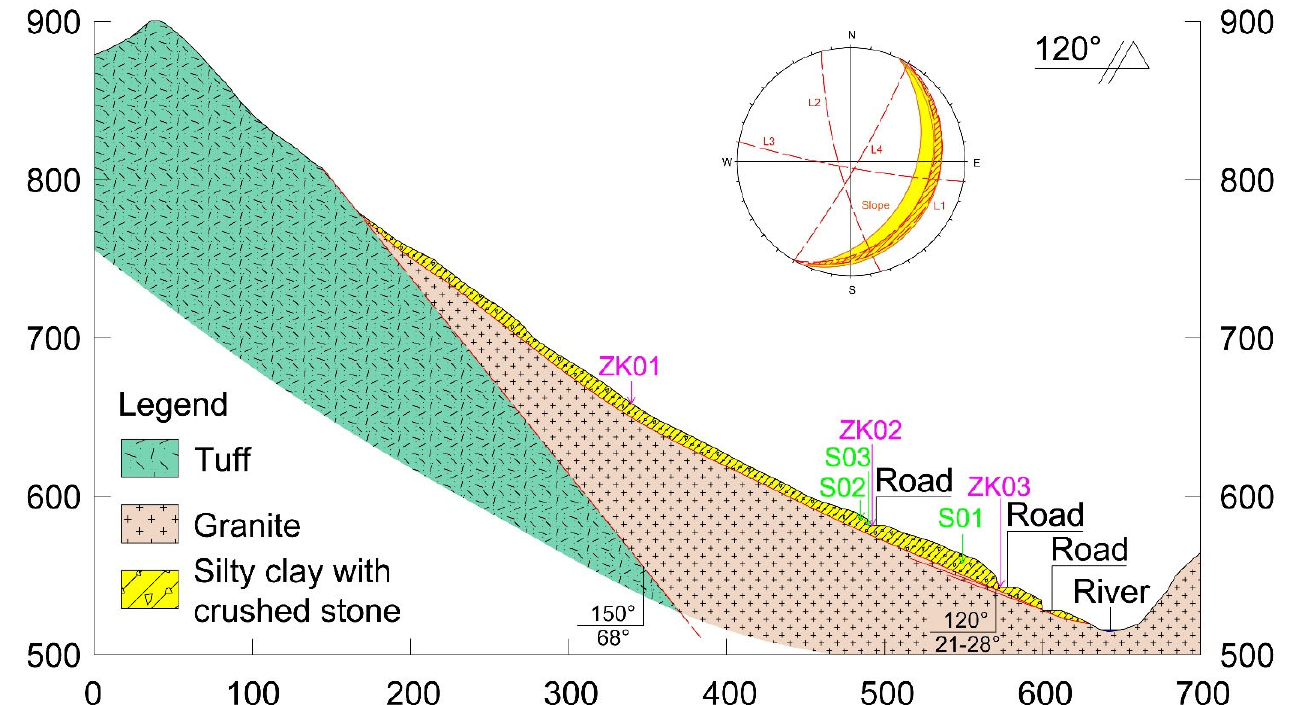
Figure 8. Shangfang landslide engineering geological profile.